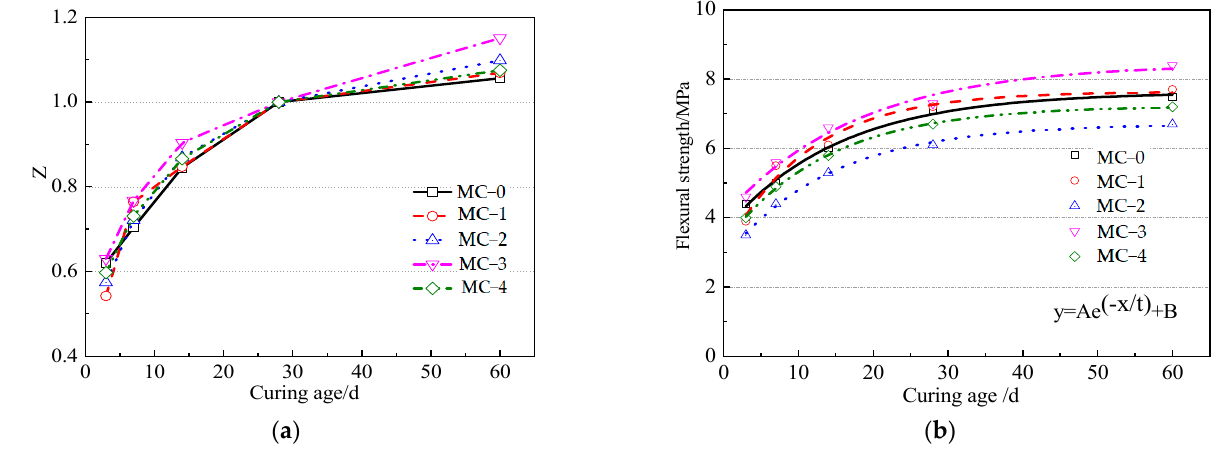
strength of NCM is NMK > NMA >ordinary cement mortar. After 14 days, the growth rate is the same.